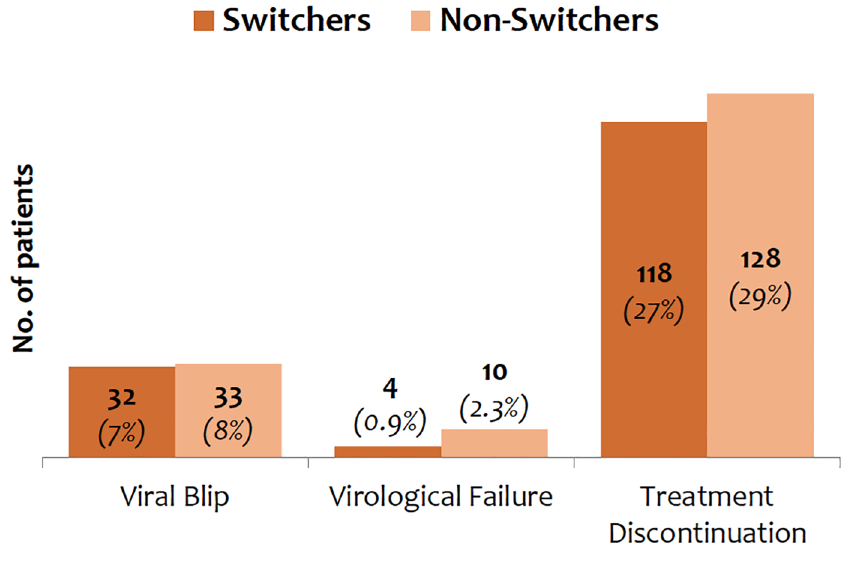
Fig 1. Main outcomes among switchers to generic compounds and non-switchers.